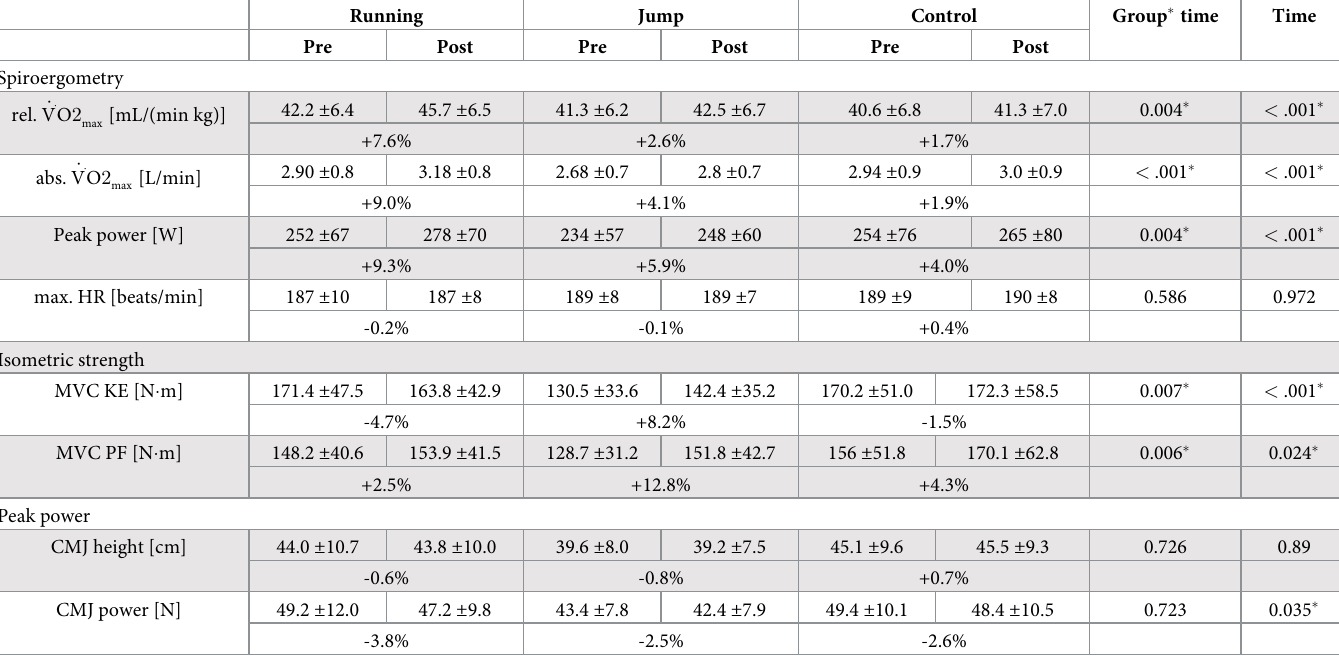
Values expressed as mean ± SD, separately for the Control, Running, and Jump group, before (pre) and after (post) the 6 weeks. Percent values reflect the average increase or decrease at the post-measurements compared to pre-tests. The last columns on the right contain the group � time interactions and the main effect of time, respectively. � Denotes significant p- values ( p < 0.05). rel. = relative, abs. = absolute, max. = maximal, HR = heart rate, maximal voluntary contraction = MVC, KE = knee extension, PF = plantar flexion, CMJ = countermovement jump.